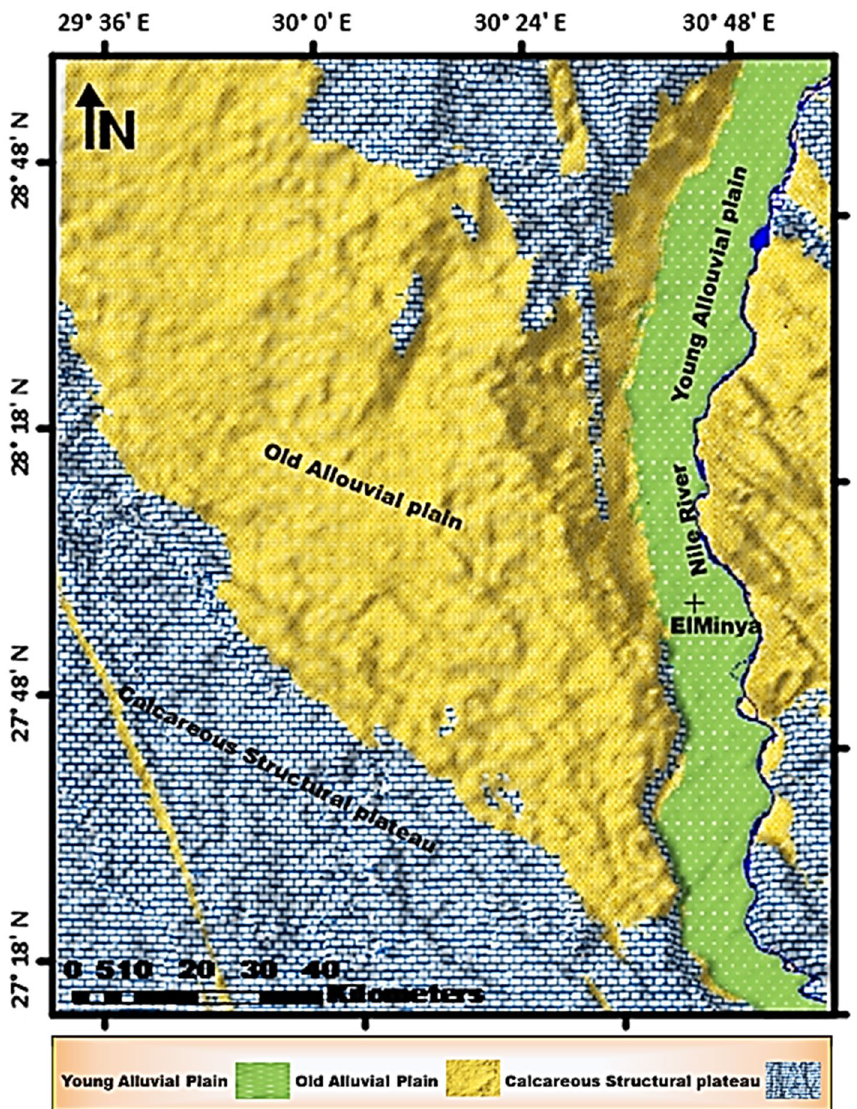
Fig. 2 Geomorphological features of West–West Minya agricultural development area, Egypt. (Modified after said,